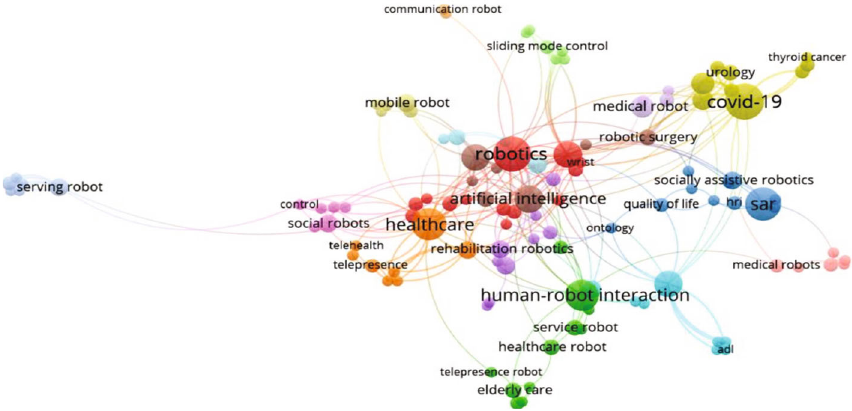
Figure 2: Co-occurrence of